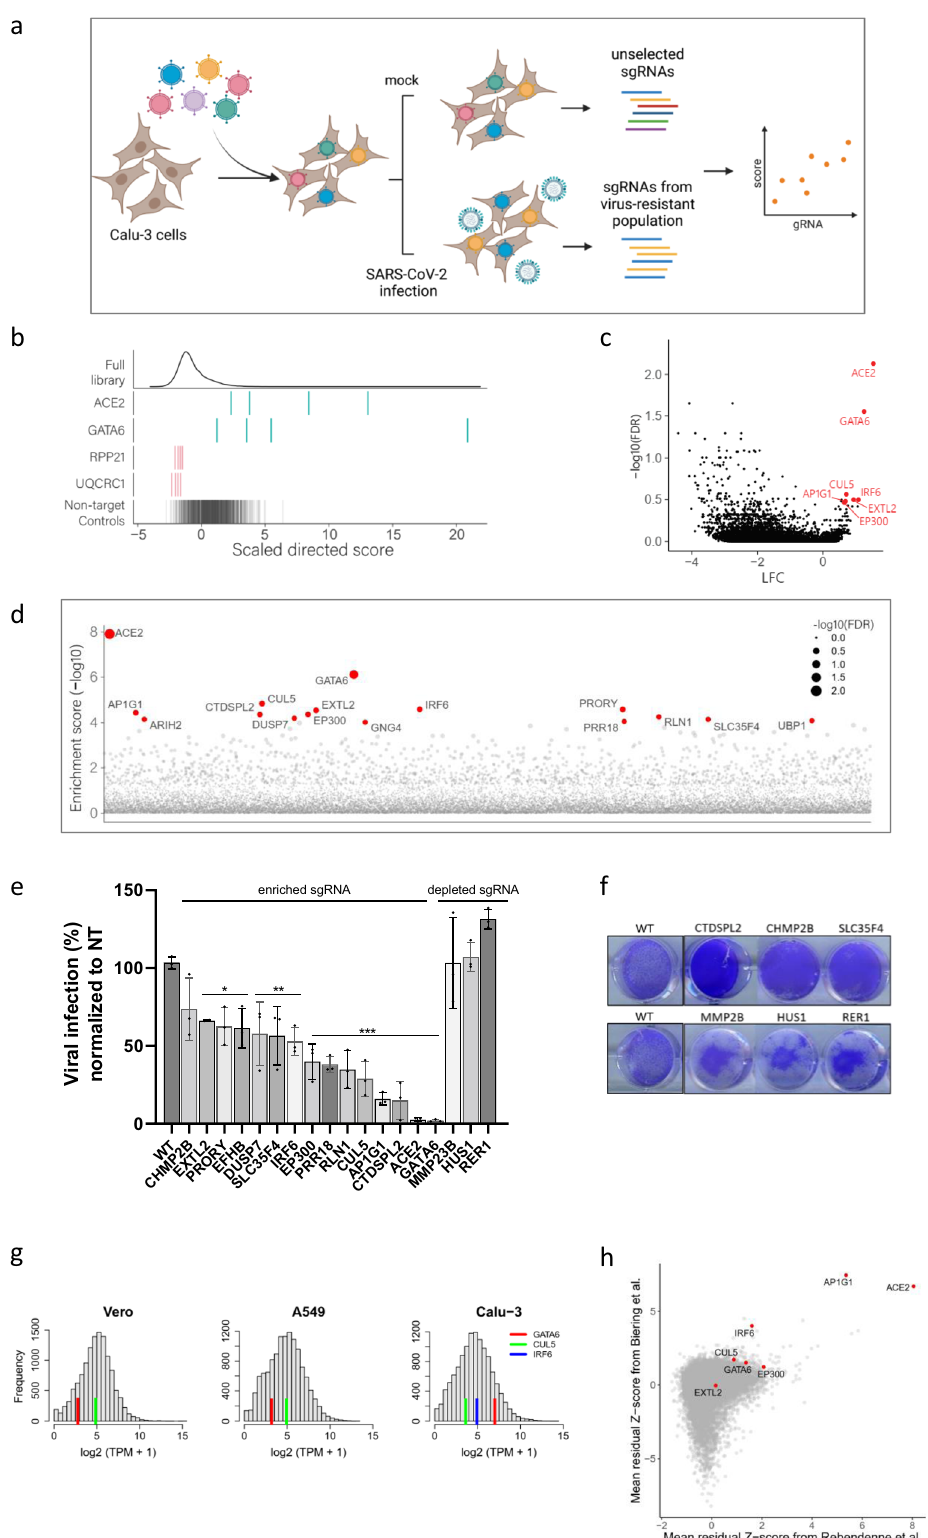
Calu-3 cells with SARS-CoV-2, irrespective of the variant, the sgRNA distributions measured in the 3 screens were collectively compared to the control non-infected cells. The analysis identi- fi ed numerous genes that upon disruption, conferred resistance to death by viral infection (referred to as proviral) or sensitization to viral infection (referred to as antiviral) (Supplementary Data